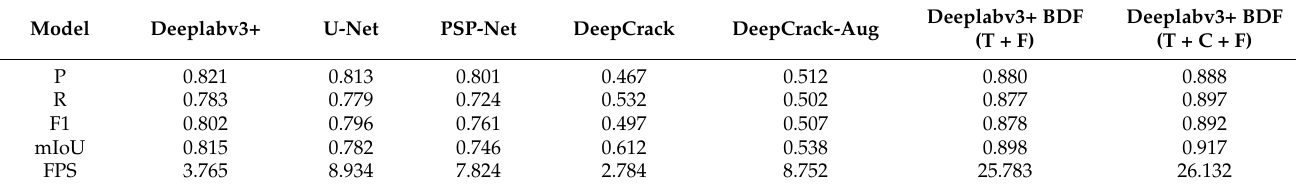
Table 3. Comparison results using the dataset of this